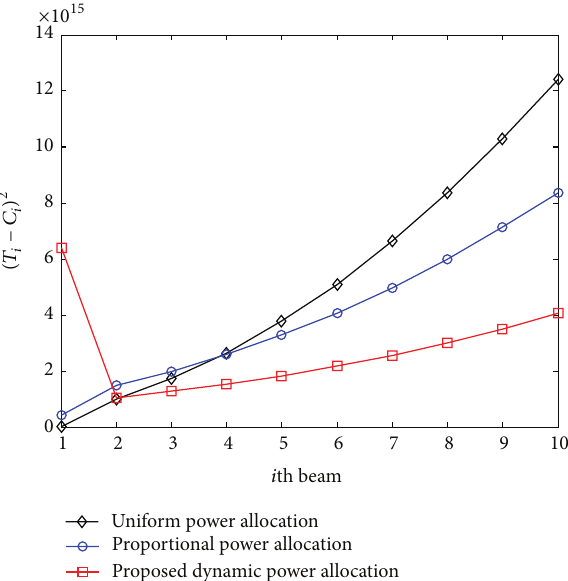
Figure 3: Distribution of the squared difference between the traffic demand and the allocated capacity of each beam, for each of the three algorithms from Scenario 1.